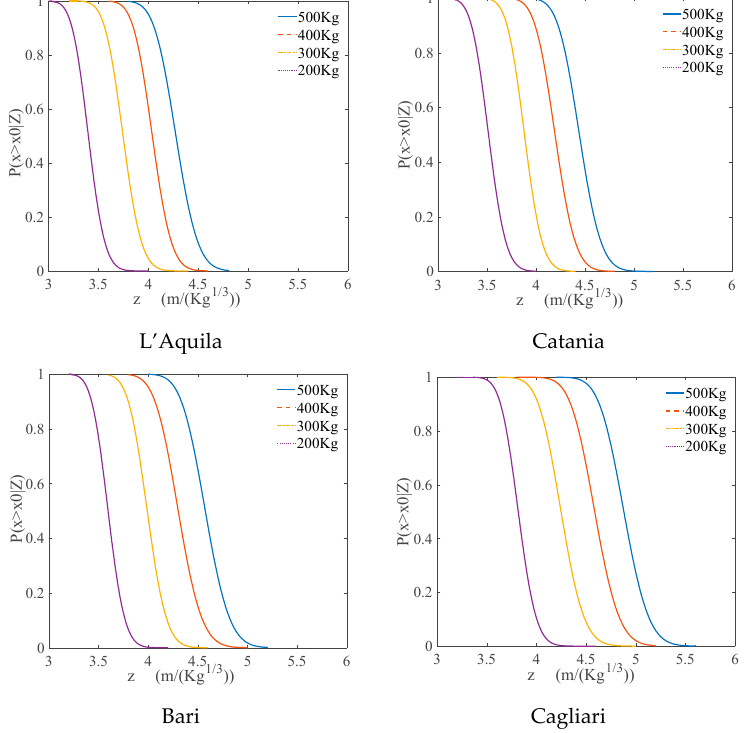
Figure 12. Fragility curves for severe damage condition for each structure location.